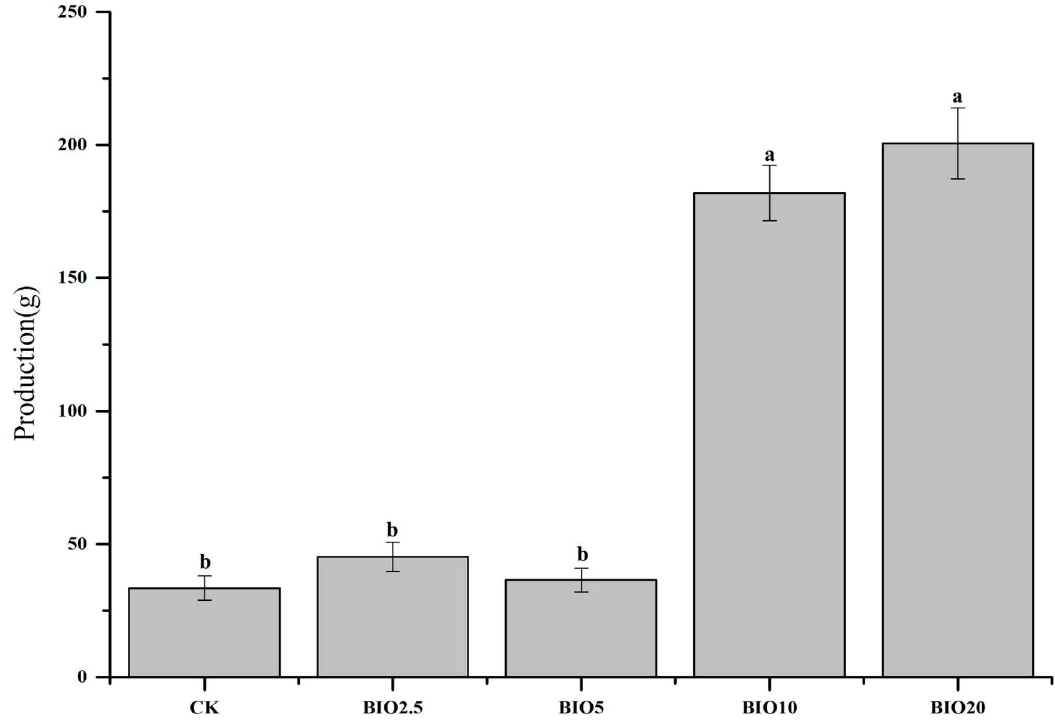
Fig 2. The production of cucumber during 90 days of growth. Columnswith different letters are significantly different accordingto Duncan’stest ( p <